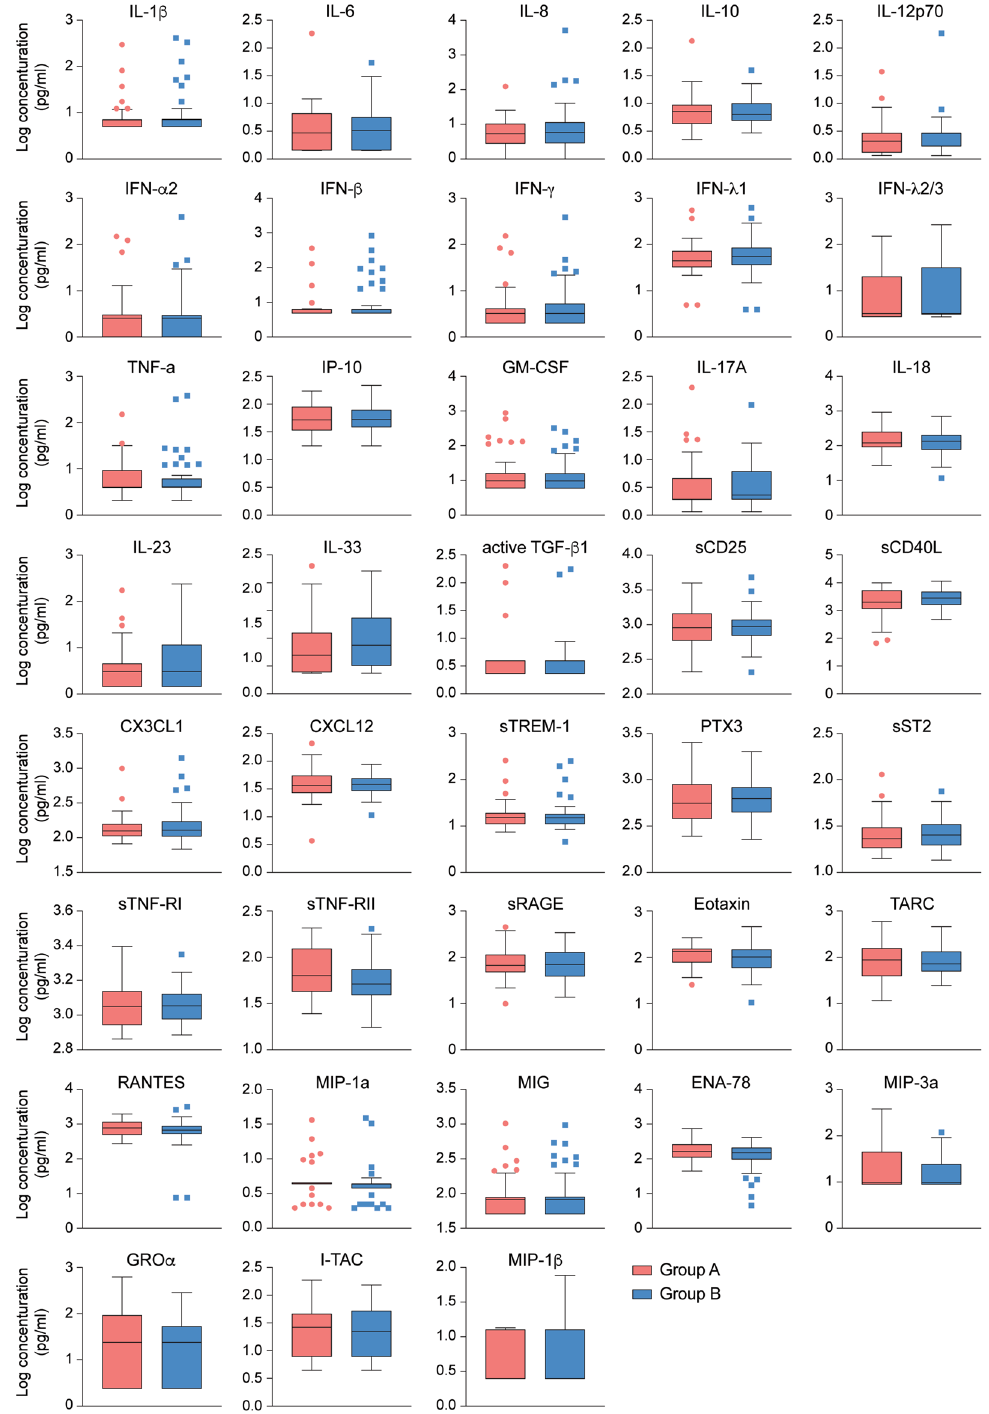
Figure 3. Comparison of cytokine and chemokine levels between asymptomatic seropositive and highly exposed seronegative cohorts. No statistically significant differences in relative steady state protein levels of 28 cytokines and 10 chemokines between asymptomatic seropositive (red, Group A, n = 41) and highly exposed seronegative (blue, Group B, n = 52) were found. Relative protein levels measured using LEGENDplex assays. Boxplots show median (middle bar), interquartile range (IQR) (box), 1.5 X IQR (whiskers). Figures were generated using GraphPad PRISM version 8.2 and Adobe Illustrator 2020 for Mac OS